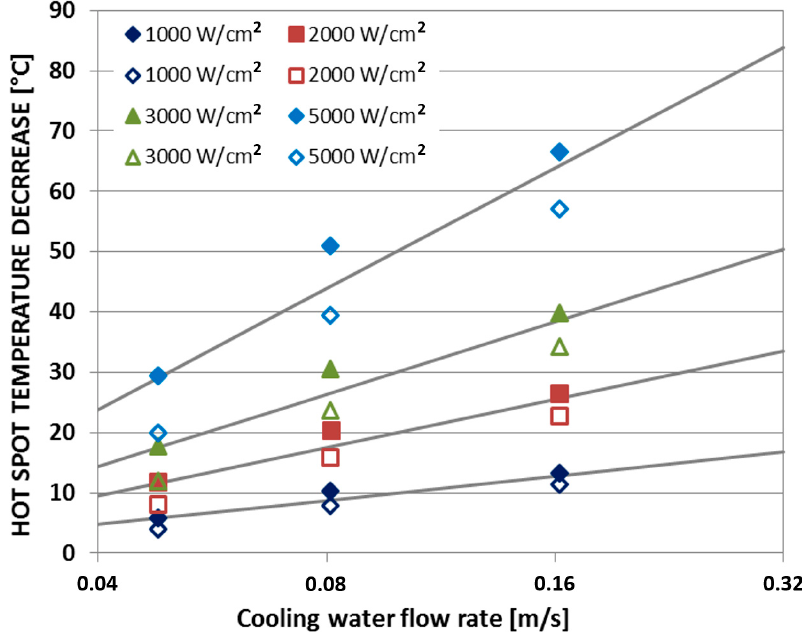
Figure 7. Hotspot temperature decrease vs. water coolant flow rate (test structure with CNT cooling fins = filled markers; test structure without CNT cooling fins = open markers). Experimental data sourced from Reference